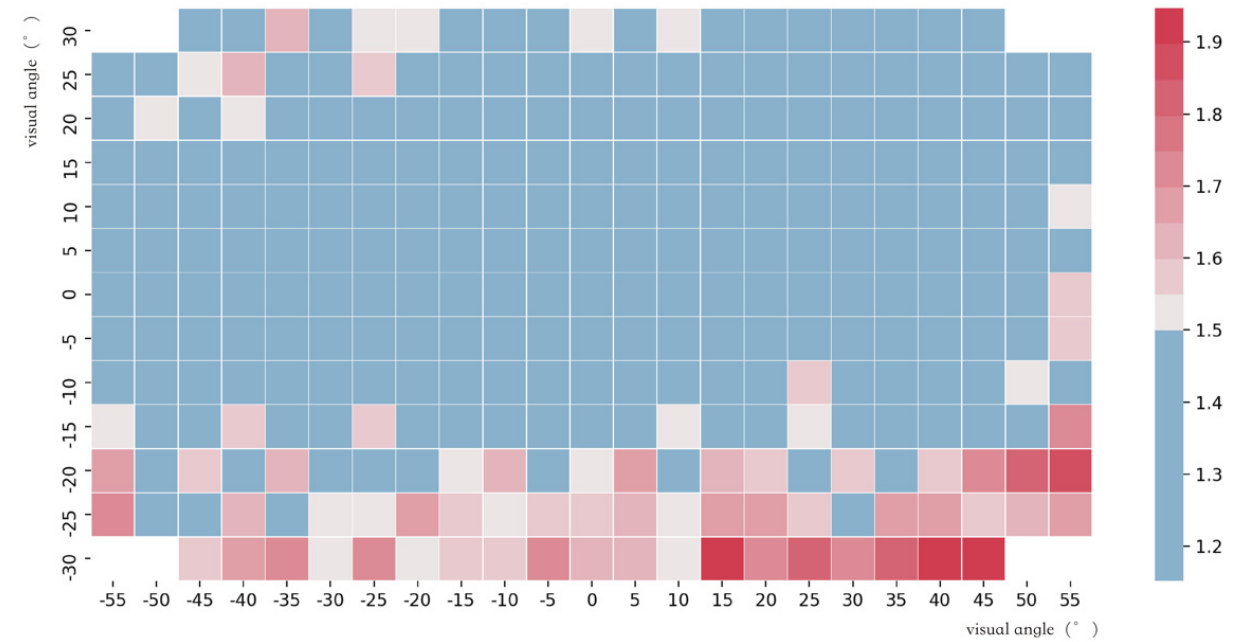
Figure 6. Heat map of click